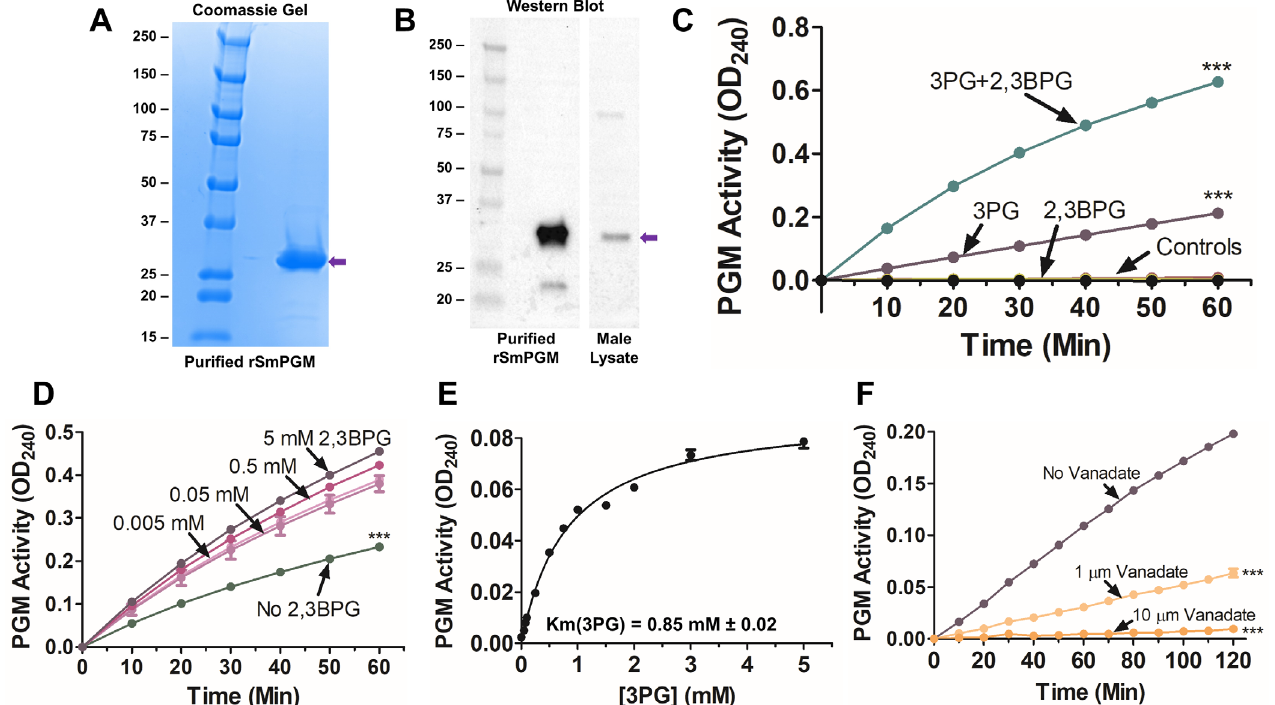
Figure 5. Expression, puri fi cation, and characterization of rSmPGM. (A) Coomassie Blue-stained gel showing puri fi ed rSmPGM running at ~28 kDa (purple arrow). Molecular mass markers are shown (left); numbers represent kDa. (B) Western blot showing pure rSmPGM (left) detection using a commercial anti-PGM antibody. A prominent protein band running at the expected size of SmPGM is detected in adult S. mansoni male lysate (right, purple arrow). Numbers to the left of the Coomassie and western blots indicate molecular markers representing molecular mass in kDa. (C) rSmPGM activity in the presence of either substrate 3PG only (purple line) or 3PG plus cofactor 2,3BPG (teal line, top). One notable control includes reaction in the presence of 2,3BPG only. Other controls include samples lacking 3PG, enolase, or rSmPGM. *** p < 0.001 (two-way ANOVA with Bonferroni post-test). (D) rSmPGM activity in the absence of 2,3BPG (3PG Only, green line) or supplemented with 0.005 – 5.0 mM 2,3BPG (pink and purple lines). *** p < 0.001 (two-way ANOVA with Bonferroni post-test). (E) Michaelis-Menten kinetic curve shown for the substrate 3PG. The K m value shown is the mean from three independent experiments. (F) Inhibition of rSmPGM activity by 1 l M (light orange line) or 10 l M (dark orange line) sodium metavanadate. Samples with no inhibitor (purple line) served as a control. *** p < 0.001 (two-way ANOVA with Bonferroni post-test at 120